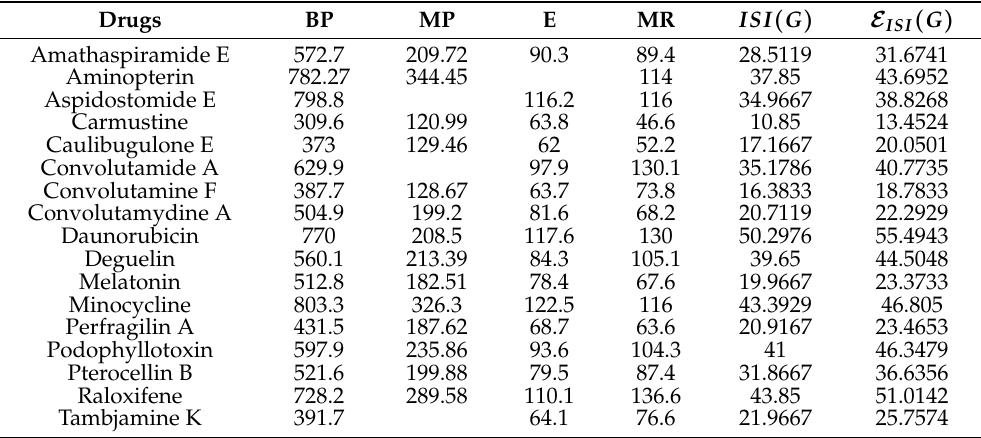
Figure 4. Logarithmic Regression for Physical Property with the ISI -index and E ISI of Anticancer Drugs. Table 1. Various Anticancer Drugs with their Physicochemical Properties and the ISI -Index (Energy) of their Chemical Structures.